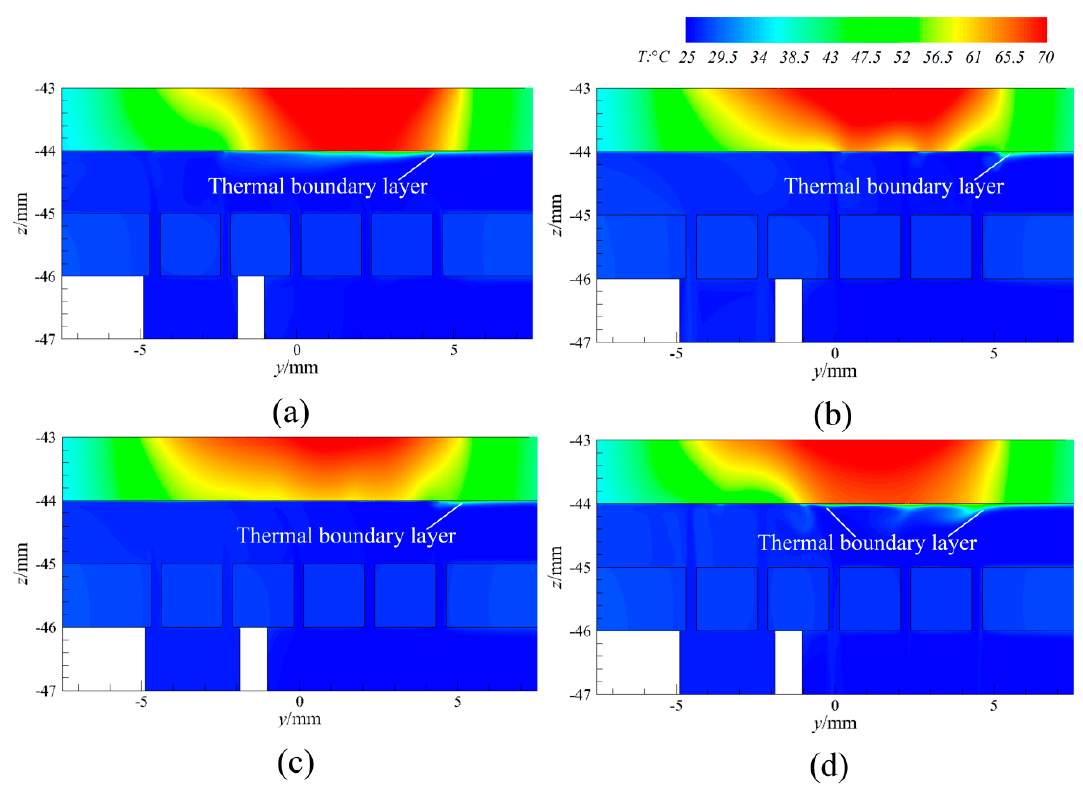
Figure 8. Temperature distribution of channel’s center section ( x = 28.5 mm) (DSJ on): ( a ) 0 T (1 T); ( b ) 0.25 T; ( c ) 0. 5 T; ( d ) 0.75 T.